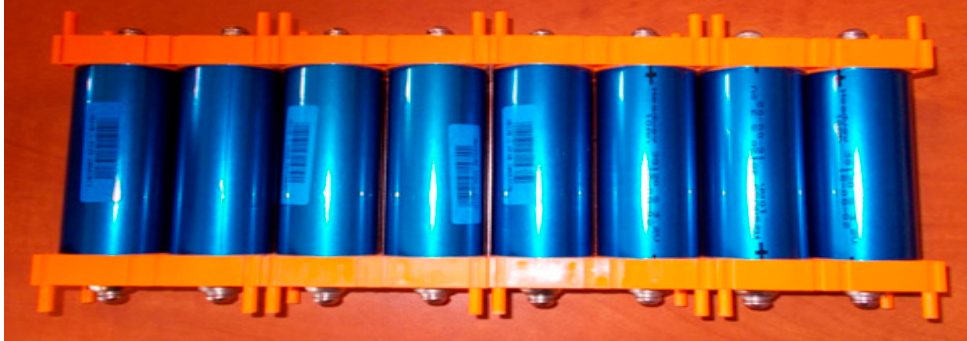
Figure 5. Battery pack arranged of eight lithium-iron-phosphorous (LiFePO 4 ) cells for testing.